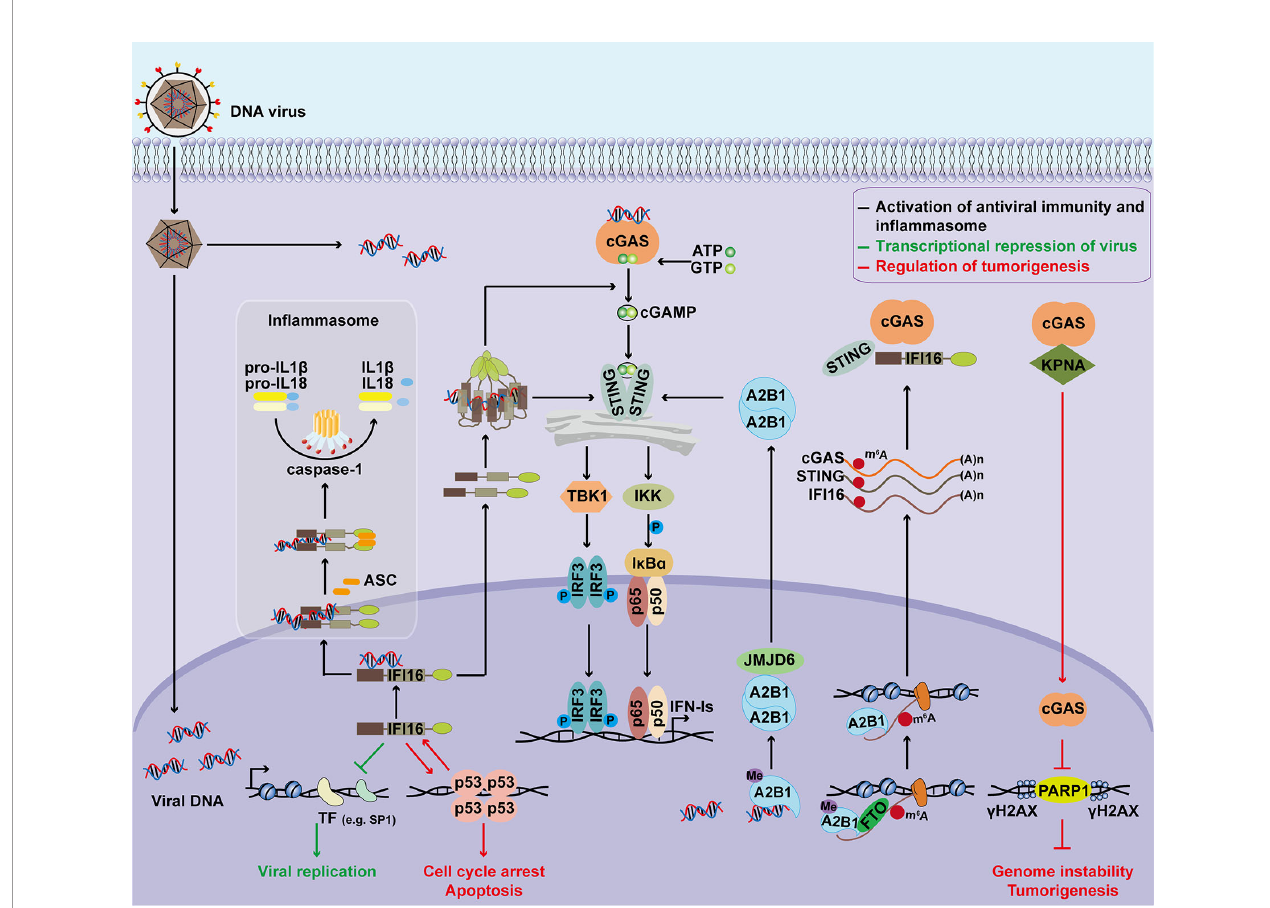
FIGURE 1 | Major functions of nuclear DNA sensors. Upon detecting nuclear viral DNA, IFI16 is transported to the cytoplasm to activate the STING signaling cascade, inducing IFN ‐ Is expression through the TBK1 ‐ IRF3 and NF ‐ k B axis. IFI16 also activates in fl ammasome to promote IL-1 b and IL-18 maturation. Additionally, IFI16 functions as a transcriptional repressor to restrict viral replication by associating with transcription factors or promoters, preventing transcription factors from binding to promoters, and inducing chromatin marker changes. Nuclear hnRNPA2B1 dimerizes and is demethylated by JMJD6 after binding to viral dsDNA, resulting in the cytoplasmic translocation of hnRNPA2B1. The cytoplasmic hnRNPA2B1 activates the STING-TBK1-IRF3 signal to facilitate the transcription of IFN-Is. Moreover, demethylated hnRNPA2B1 enhances nucleocytoplasmic traf fi cking and translates cGAS, STING, and IFI16 mRNAs to amplify the antiviral immune response. Besides, the roles of nuclear DNA sensors during tumorigenesis have also been investigated. IFI16 is shown to act as a tumor suppressor in several types of cancers by interacting with p53 and enhancing p53-mediated transcriptional activation. In turn, functional activation of p53 stimulate the transcription of IFI16 through associating with the regulatory region of the IFI16 promoter. DNA damage triggers nuclear translocation of cGAS. Nuclear cGAS promotes tumorigenesis by modulating the DNA damage response and increasing genomic instability. ASC, apoptosis-associated speck-like protein containing a CARD; STING, stimulator of interferon genes; TBK1, TANK-binding kinase 1; IKK, I k B kinase; IRF3, interferon regulatory factor 3; IFN-I, type I interferon; A2B1, hnRNPA2B1; JMJD6, jumonji domain containing 6; Me, methylation; m 6 A, N 6 -Methyladenosine; FTO, fat mass and obesity-associated protein; KPNA, karyopherin alpha; PARP1, Poly